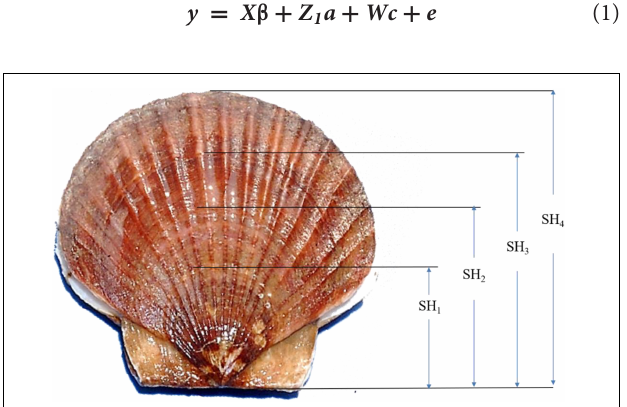
FIGURE 1 | Shell height growth was indicated by the rings in the outer shells of the yesso scallop in this study. SH 1 , shell height at 6 months; SH 2 , shell height at 10 months; SH 3 , shell height at 16 months; SH 4 , shell height at 20 months.